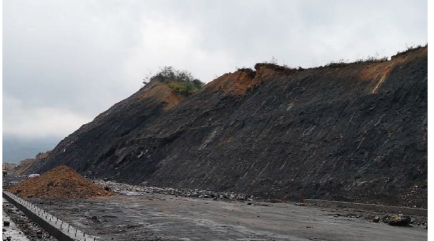
Figure 1: Carbonaceous mudstone at the embankment site.